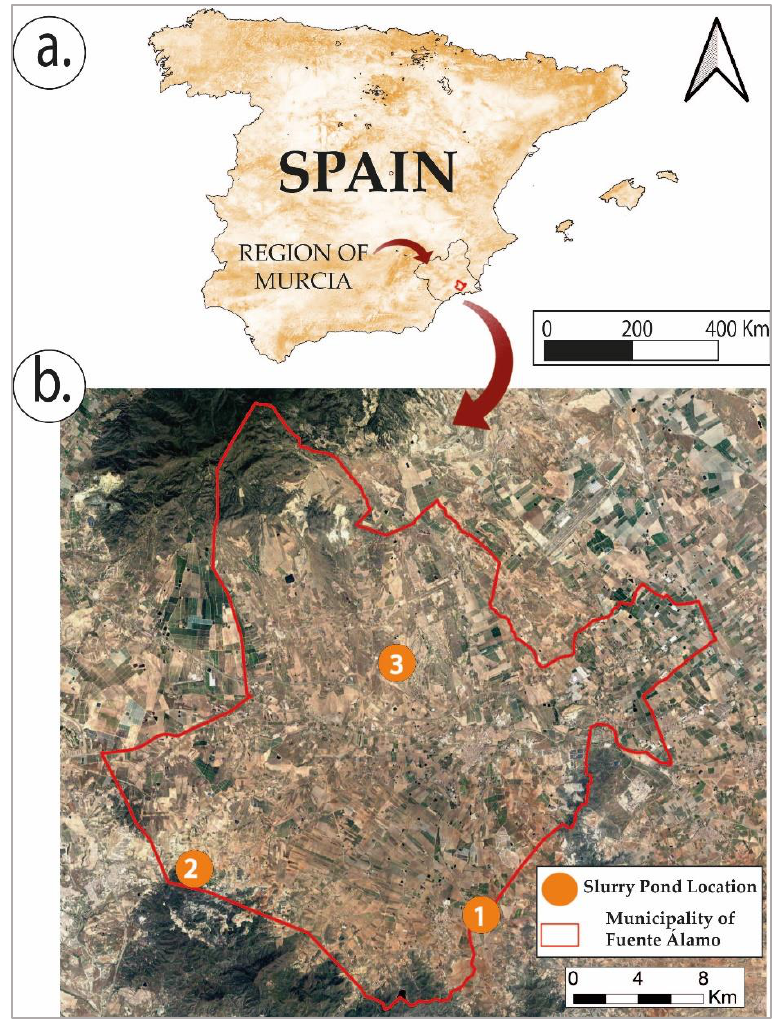
Figure 1. Geographical location of ( a ) the municipality of Fuente Á lamo, and ( b ) the three studied slurry ponds.